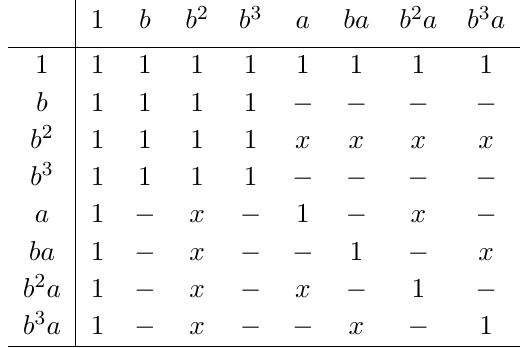
Table 4 . Table of invariant phases (cid:15) ( g, h ) = C ( g, h ) /C ( h, g ) using the cocycles in table 3. An entry ‘ − ’ indicates a non-commuting